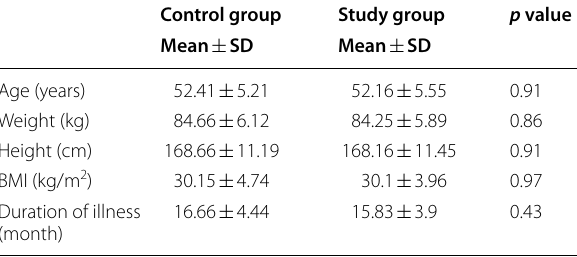
p value: level of significance (<